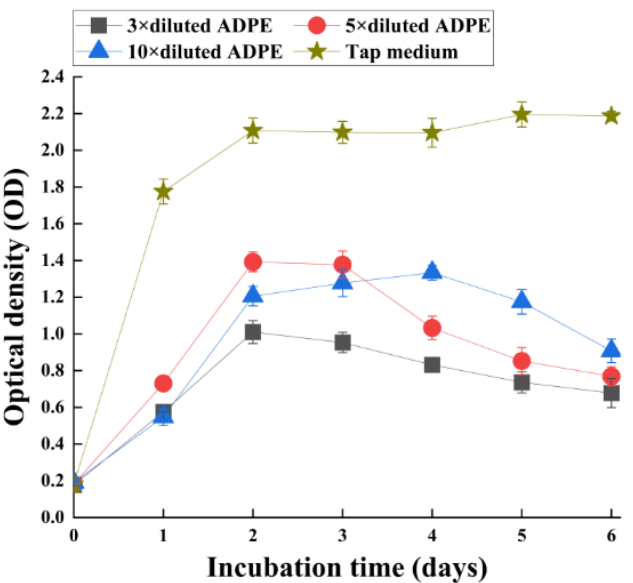
Figure 5. Growth curve of NCU-39 in different diluted anaerobic digestion piggery effluents (ADPEs) (3-fold (3 × ), 5 × , and 10 × dilution) pretreated by 3-day fungal decolorization. Tap medium was used as a control. Error bars represent standard deviations ( n = 3).